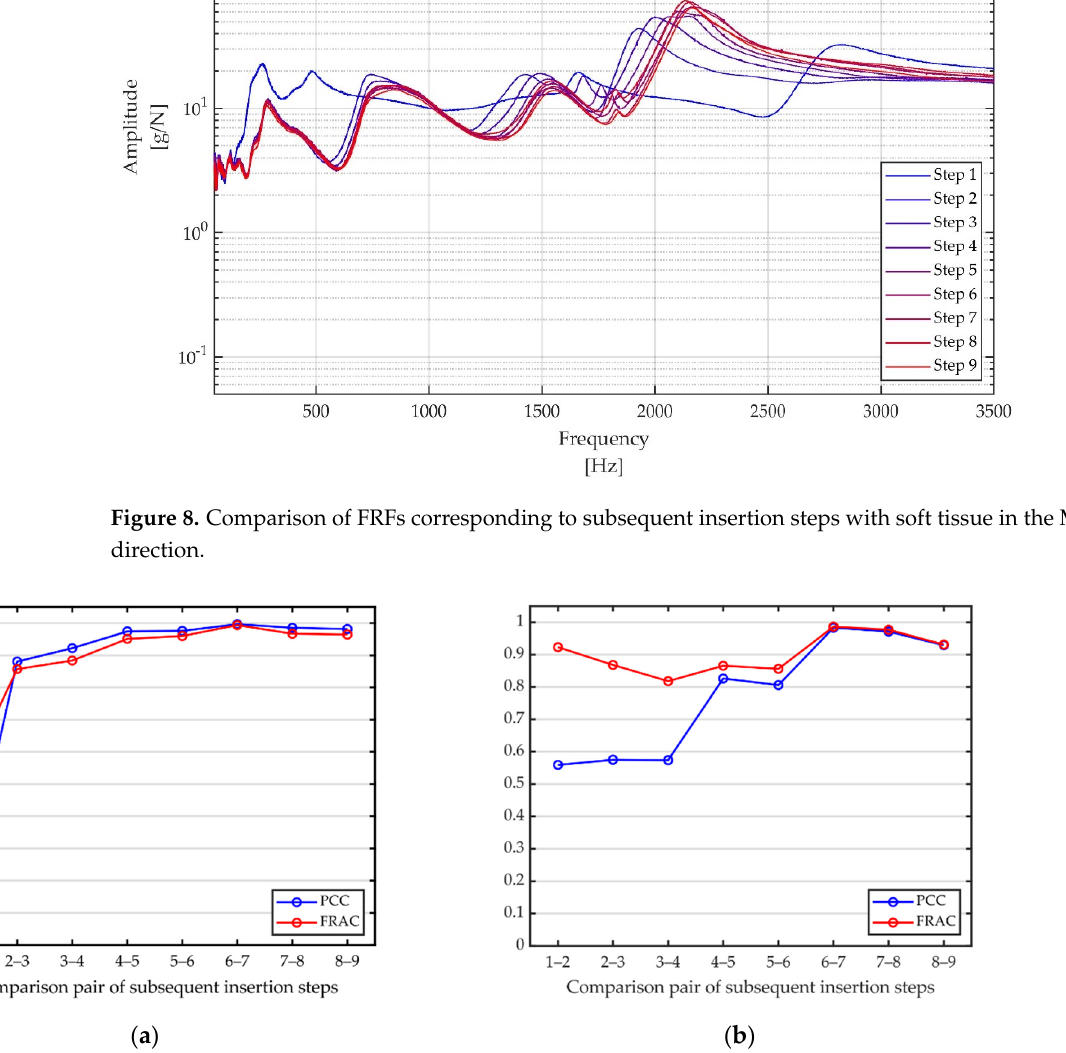
Figure 9. ( a ) PCC versus FRAC development during insertion with soft tissue in AP direction. ( b ) PCC versus FRAC development during insertion with soft tissue in ML direction.